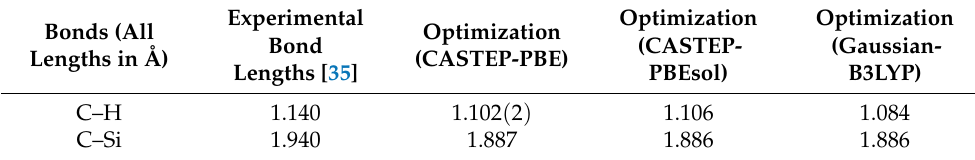
Table 4. Optimized bond lengths of the Si ( CH 3 ) 4 .